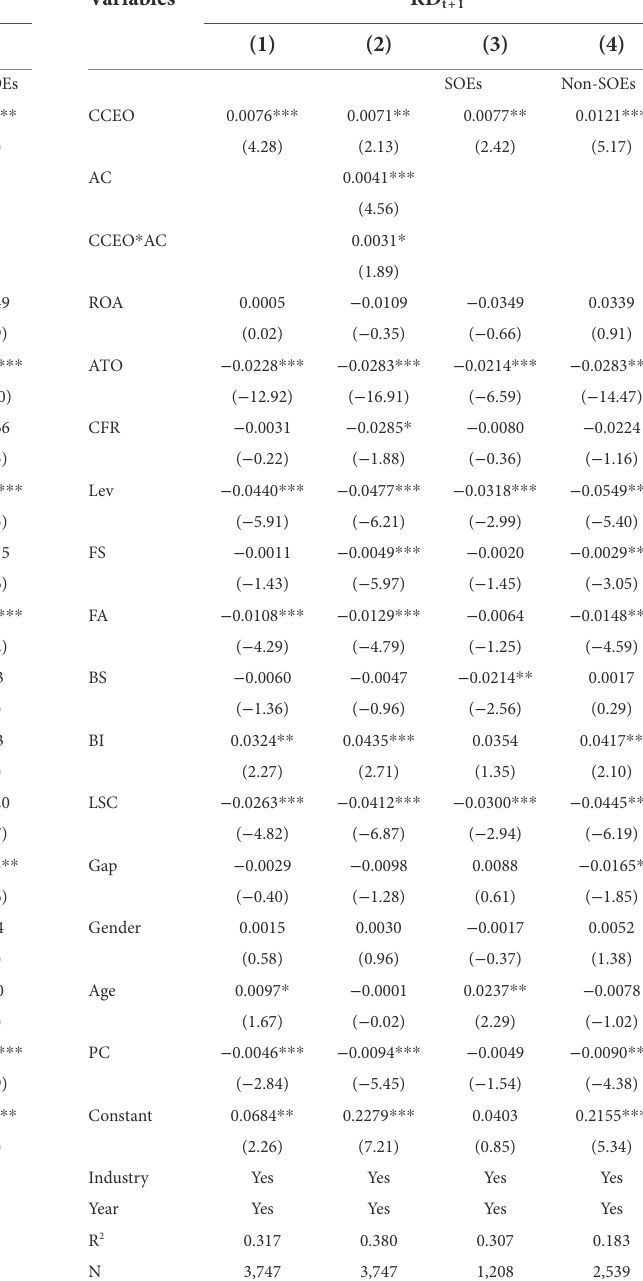
TABLE 4 Regression analysis results. TABLE 5 Robustness test: Propensity score matching